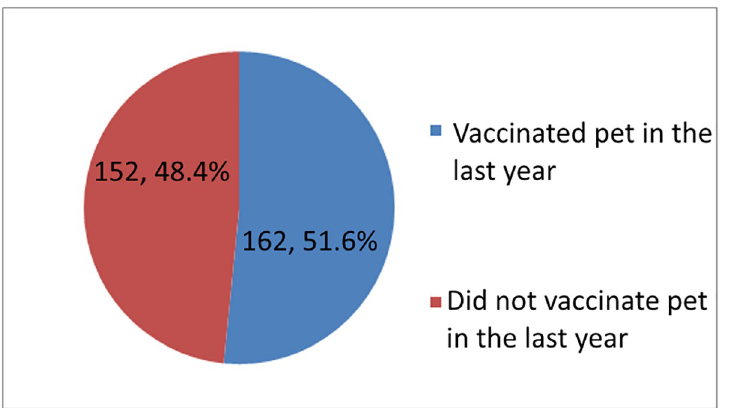
Fig 2. Number of respondents that vaccinated pets in the last